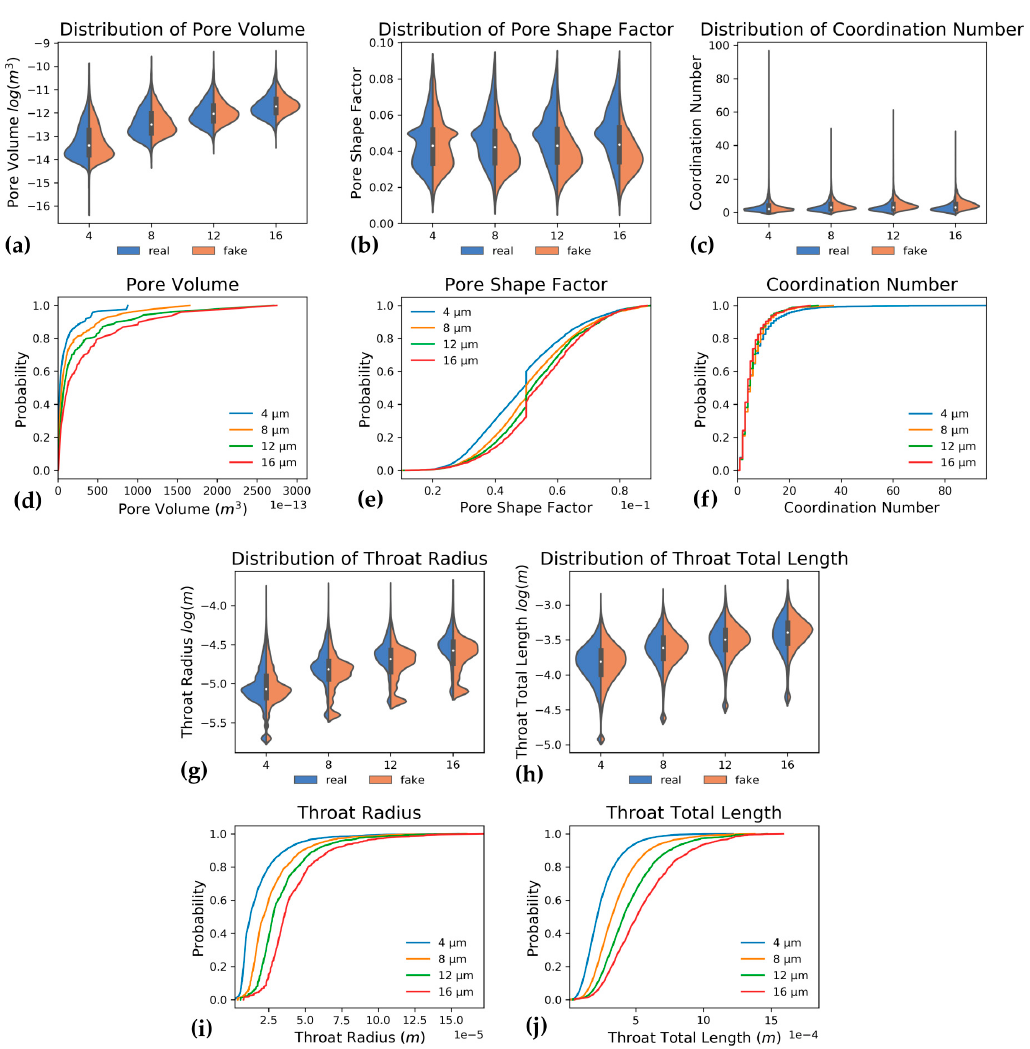
Figure 6. Study of resolution effect. Pore network properties showing the influence of resolution (in µm) in cumulative distribution plots, while violin plots also show how these properties vary for artificial (fake) versus mechanical (real) resolution reduction. In cumulative distribution plots, only the mechanically reduced resolution is shown. Data from first volume (V1). Pore volume ( a , d ) increases with decreasing volume, pore shape factor ( b , e ) increases for MRR (real) and decreases for ARR (fake), coordination number ( c , f ) is constant for MRR (real) and raises for ARR (fake). Pore throat radii ( g , i ) and lengths ( h , j ) decrease with improving resolution.